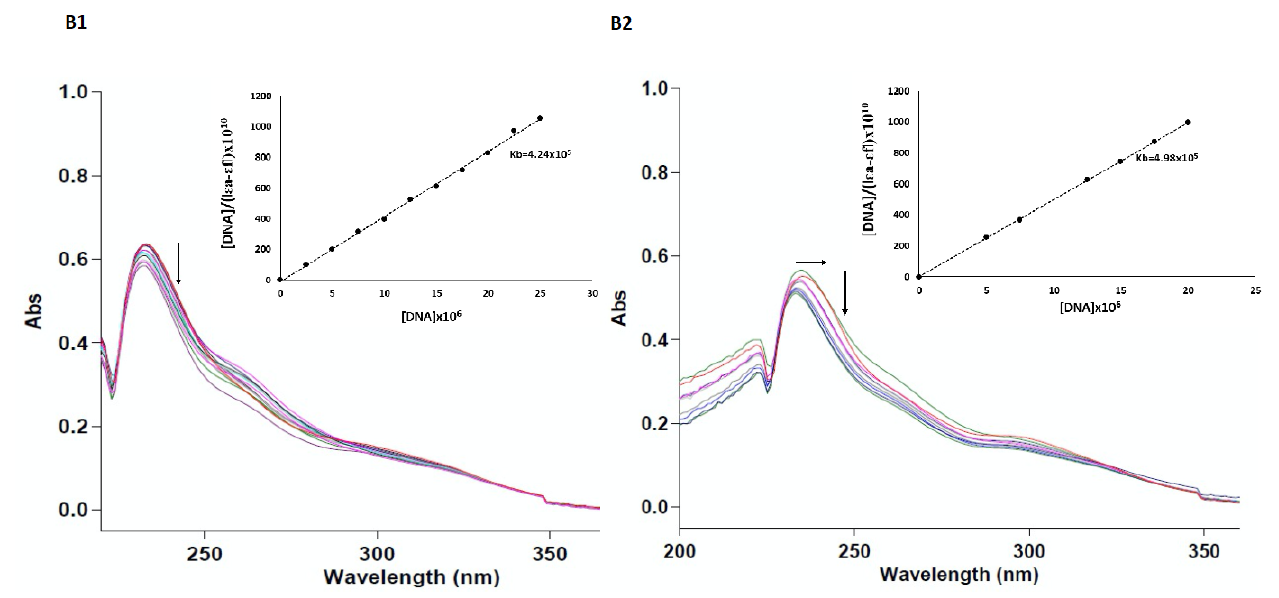
Figure 5. Absorption spectra of compounds B1 and B2 upon gradual addition of CT-DNA. The arrows show the absorbance change upon increasing the DNA concentration. The corresponding plots of [DNA]/(|εA − εF|) vs. [DNA] are also given.